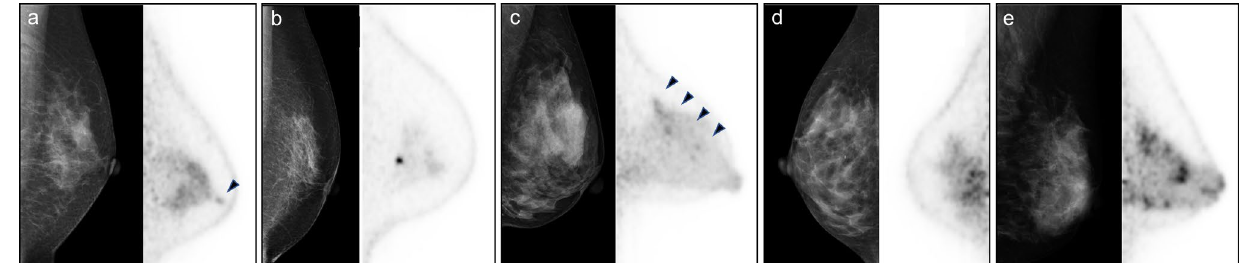
Figure 2. Representative images of incidental findings on dedicated breast PET and the diagnosis. ( a ) Focus uptake of 4 mm in diameter with lesion-to-background ratio (LBR) of 1.06 in the left breast (arrow head) and it is diagnosed with fibroadenoma. ( b ) Focus uptake of 4 mm in diameter with LBR of 3.19 in the left breast and it is diagnosed with infiltrating duct carcinoma not otherwise specified. ( c ) Non-mass uptake with segmental distribution of 50 mm in diameter in the left breast (arrow heads) and it is diagnosed with 1.5 mm of infiltrating duct carcinoma with 48 mm of intraductal spreading. ( d ) Non-mass uptake with regional distribution in the right breast and it is diagnosed with fibroadenoma. ( e ) Non-mass uptake with diffuse distribution in the left breast and it is diagnosed with mastopathy. Left, mammography; right, dedicated breast PET image; PET, positron emission